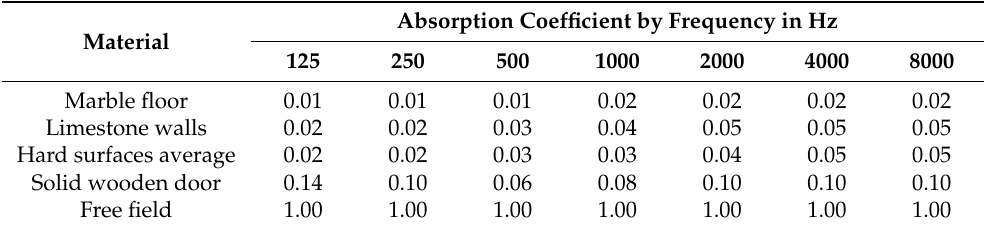
Table 2. Absorption coefficients by frequencies of the materials used in the acoustic simulation.